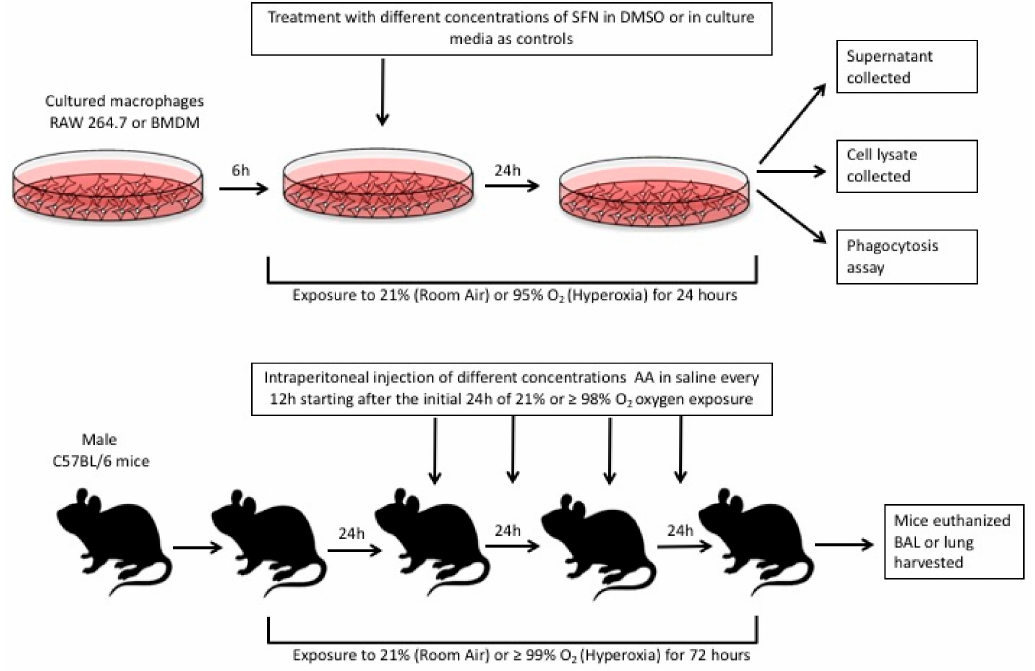
Figure 1. The in vitro studies were conducted in cultured RAW 264.7 macrophages and primary bone-marrow derive macrophages (BMDMs). Both types of cell cultures were seeded and allowed to adhere for 6 h. The culture media were then replaced with media containing sulforaphane (SFN) diluted in DMSO. These cells were either exposed to 24 h of 95% O 2 (hyperoxia) or allowed to remain at room air (21% O 2 ). After 24 h, di ff erent assays were conducted as described in the methods section. For the in vivo studies, male C57BL / 6 mice were either exposed to > 99% O 2 or room air (21% O 2 ) for 72 h. During this 72 h period, blindly randomized groups of mice were given ascorbic acid (AA) or 0.9% saline (control group) intraperitoneally as indicated above. After 72 h, the mice were euthanized and their lung lavage fluid and lung tissue were harvested for assays as described in the methods